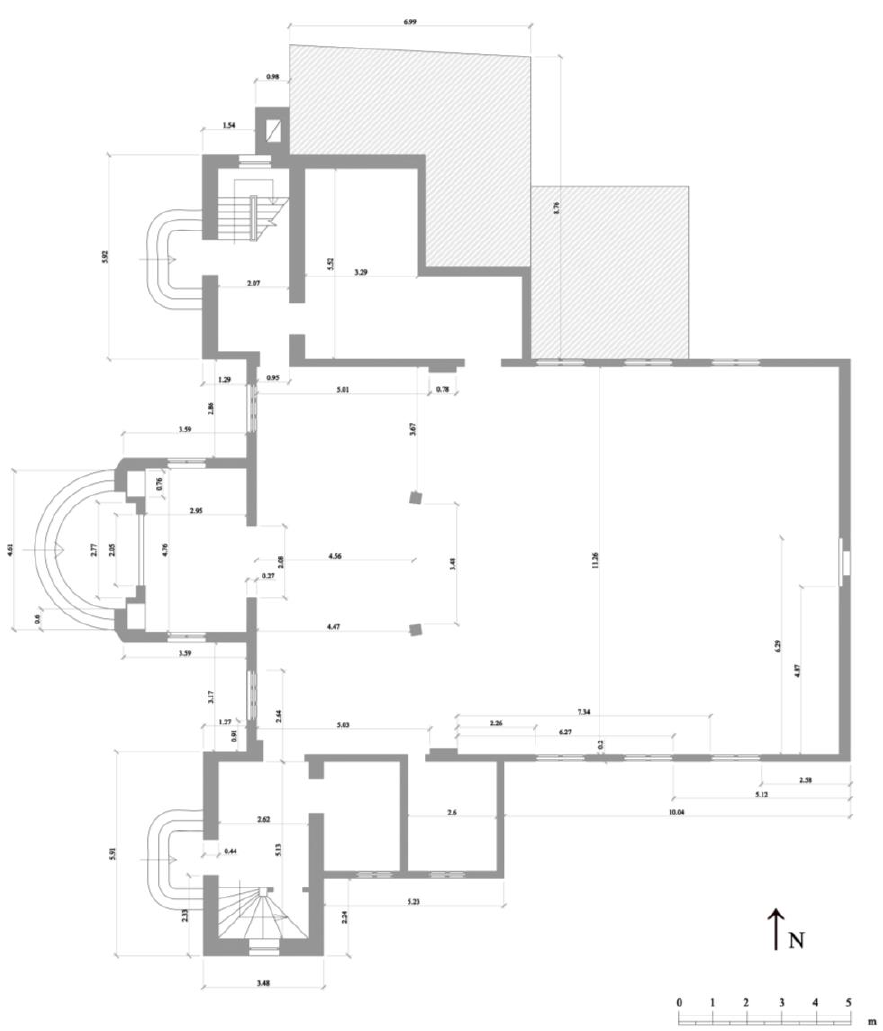
Figure 14. Majori Synagogue, ground plan. Drawing by Zoya Arshavsky, 2010. CJA. Used by permission.